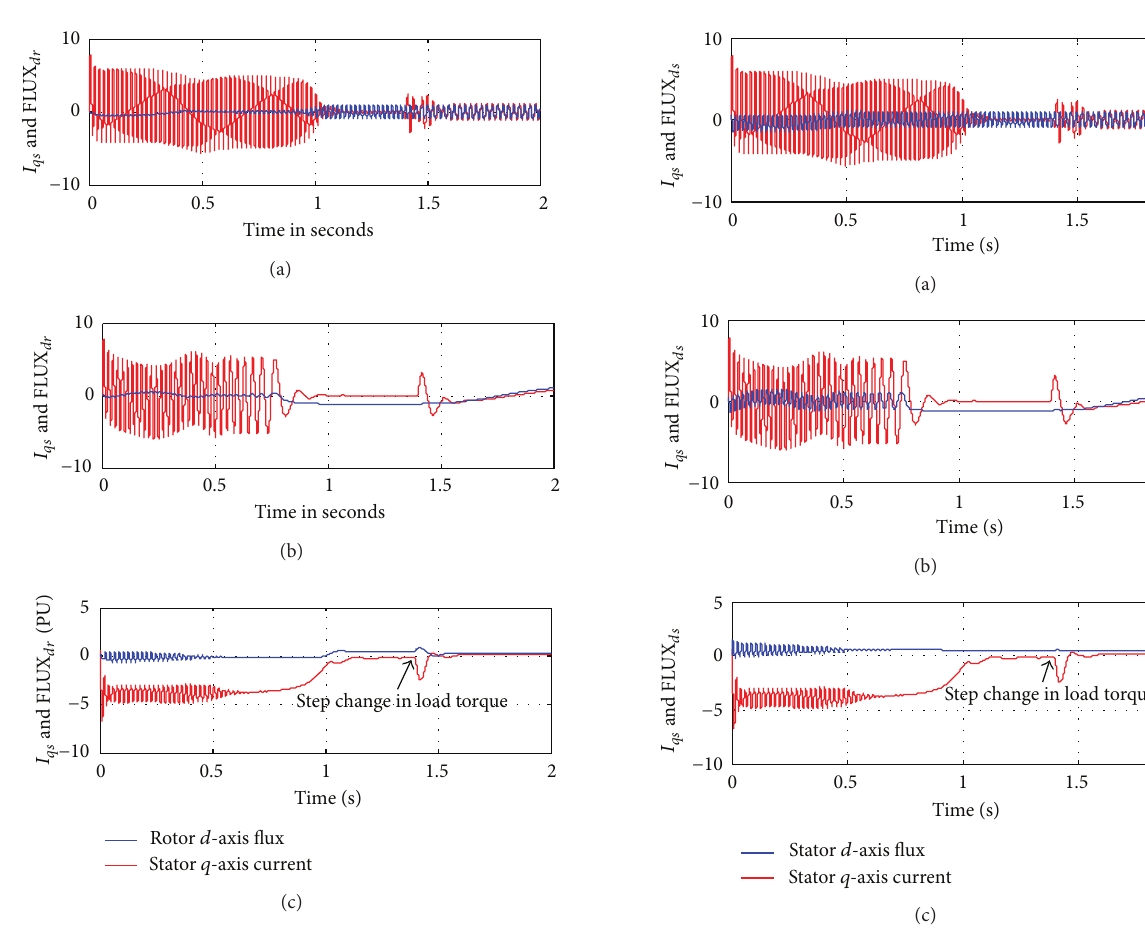
Figure 5: Simulated results of 𝑞 -axis stator current and 𝑑 -axis stator flux in different rotating reference